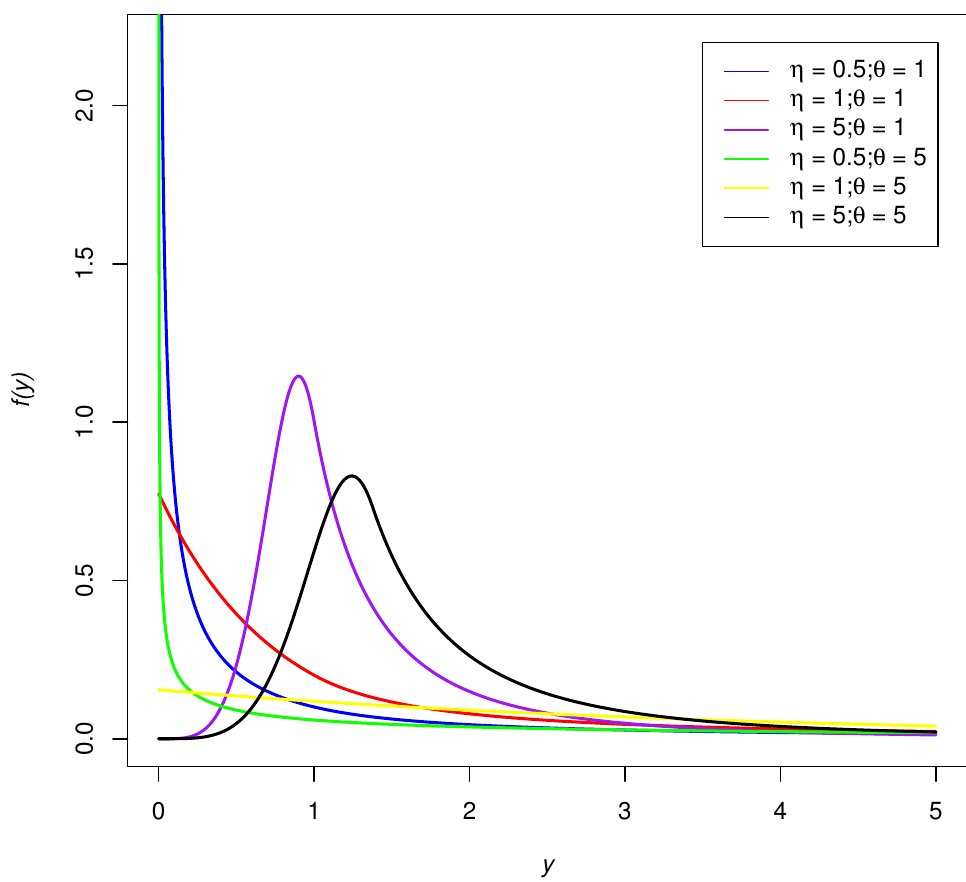
Figure 1. The pdf of an EEP distribution with different